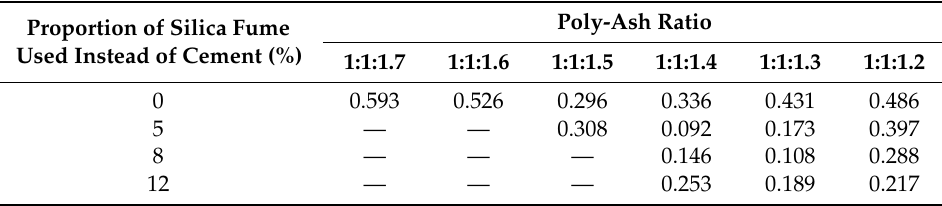
Table 5. Coefficient of variation of hexahedron